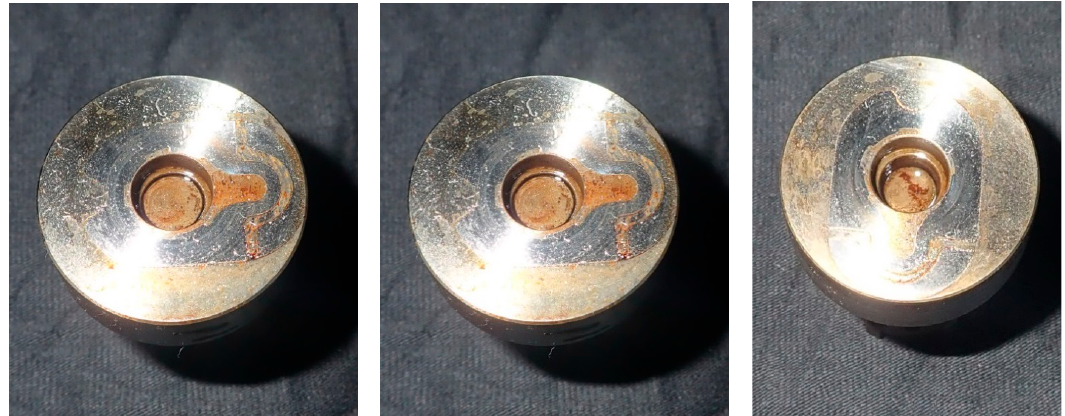
Figure 14. Pumping elements of the CP1S pump cylinders (barrel, plunger, spring). Two out of the three elements were stuck in the Top Dead Center position (end of delivery stroke).